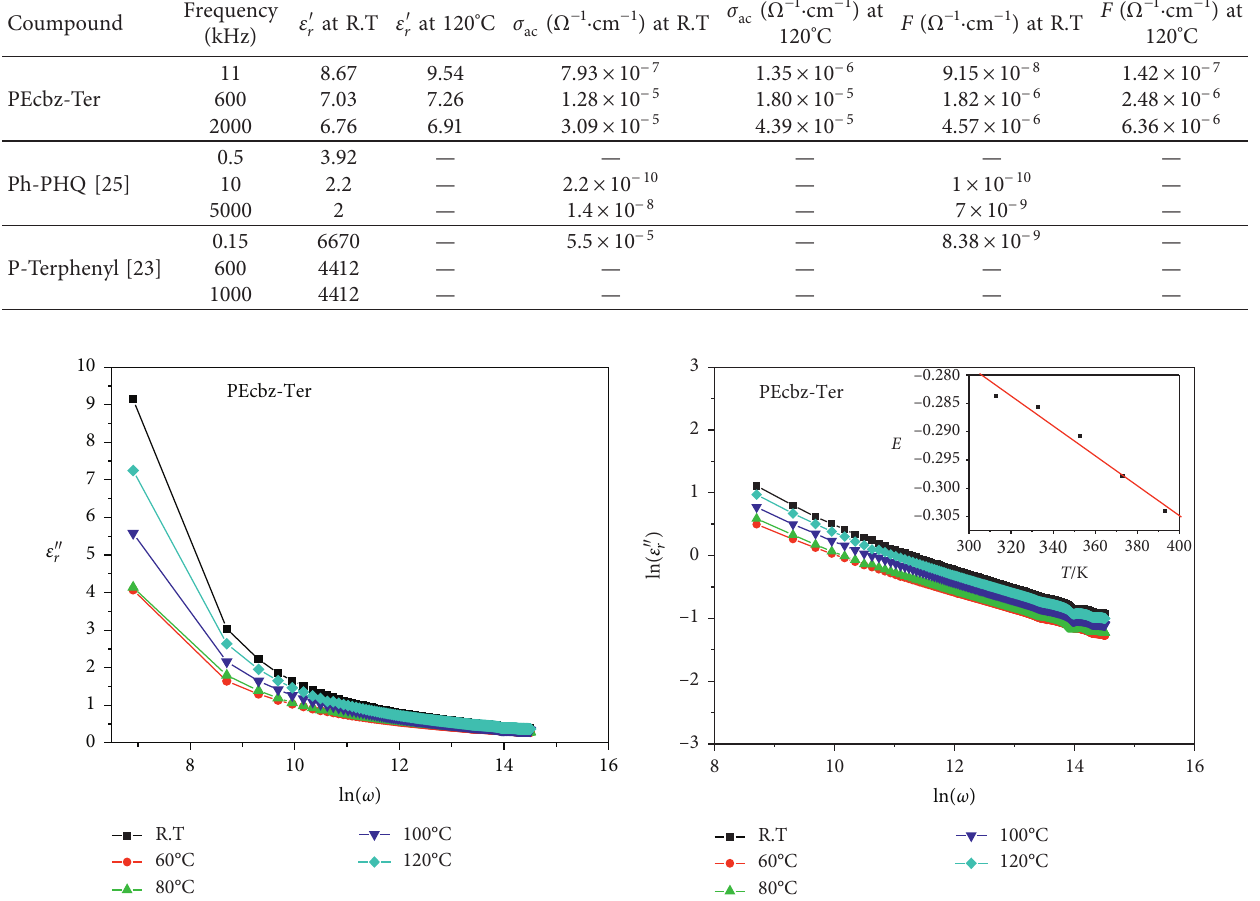
) vs. frequency of PEcbz-Ter at different temperatures. r ″